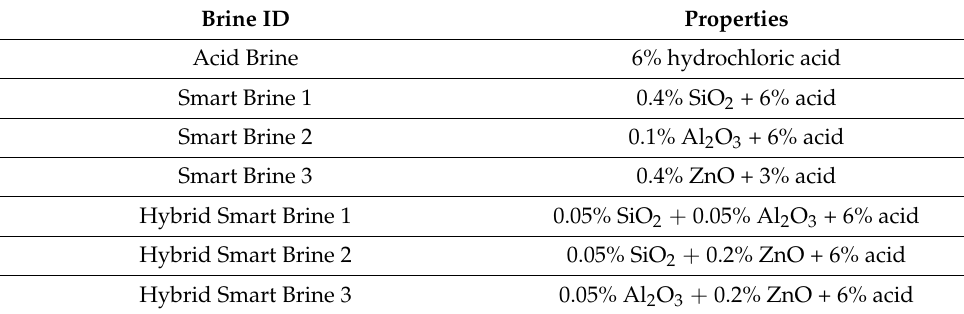
Table 6. Summary of brine properties injected for coreflooding.